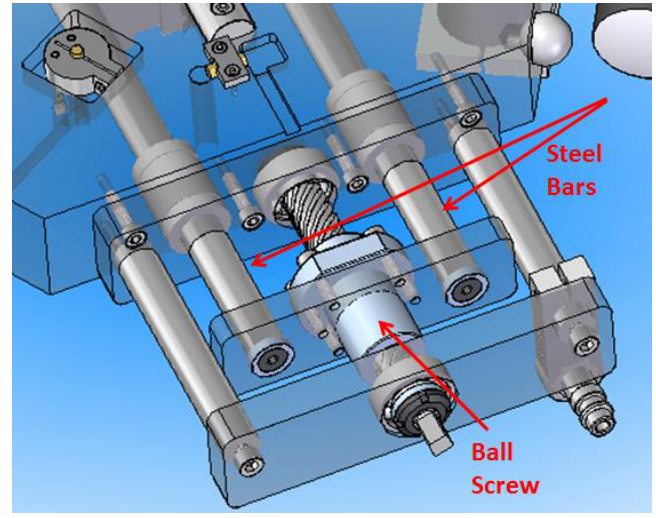
Figure 6. Ball screw and steel bars of the elevation mechanism.